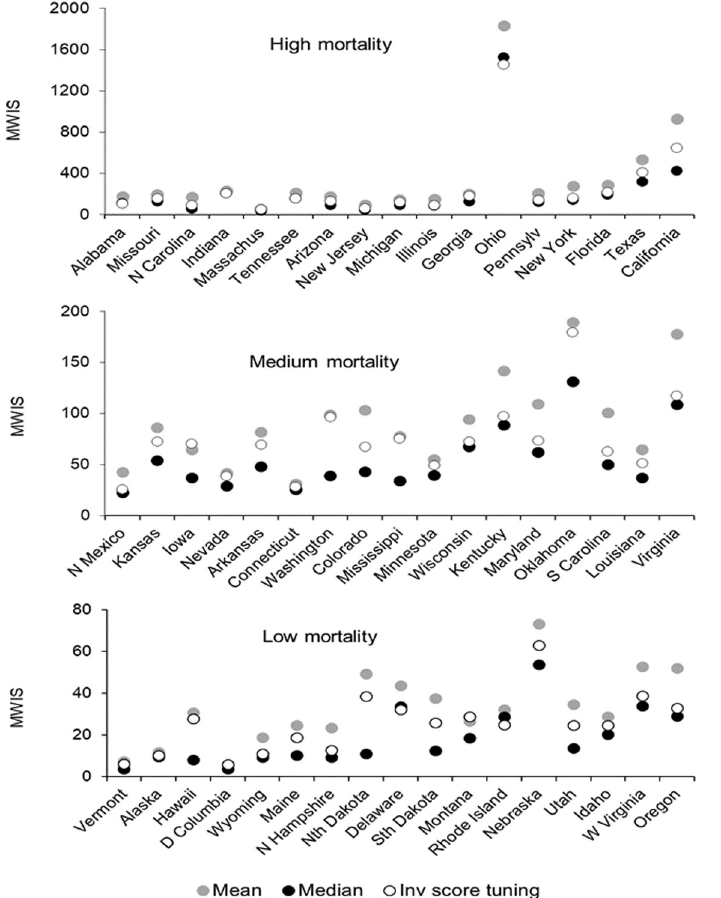
Fig 8. For cumulative mortality, MWIS for high, medium and low mortality states for three selected combining methods.